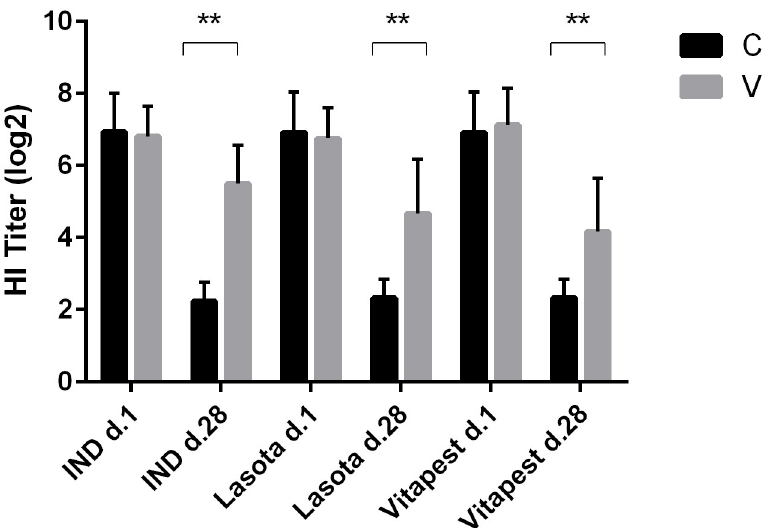
Fig 2. Antibodies levels in day old chicks (d.1) and 28 d in the control (C) and vaccinated (V) groups (n = 10 per group). Antibody was measured by Haemagglutination-Inhibition test and mean titer expressed as log 2 of serum serial dilution. Statistical differences between groups indicated as bars with star ( �� = P � 0.01).